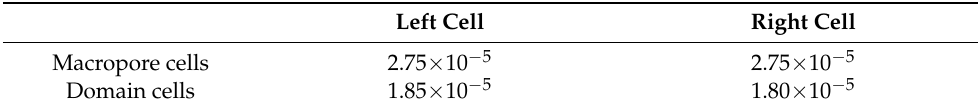
Table 3. Model liquid phase velocity results [m s − 1 ] for scenario (c) of Forchheimer–Case 2. Left Cell Right